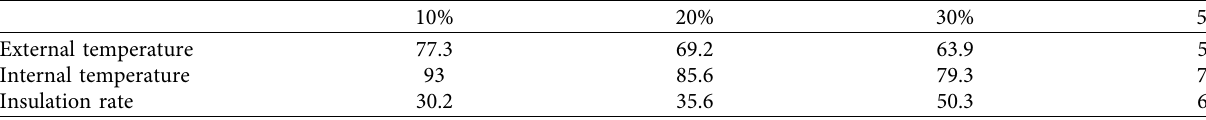
Table 4: Thermal insulation under different nanocoating densities.